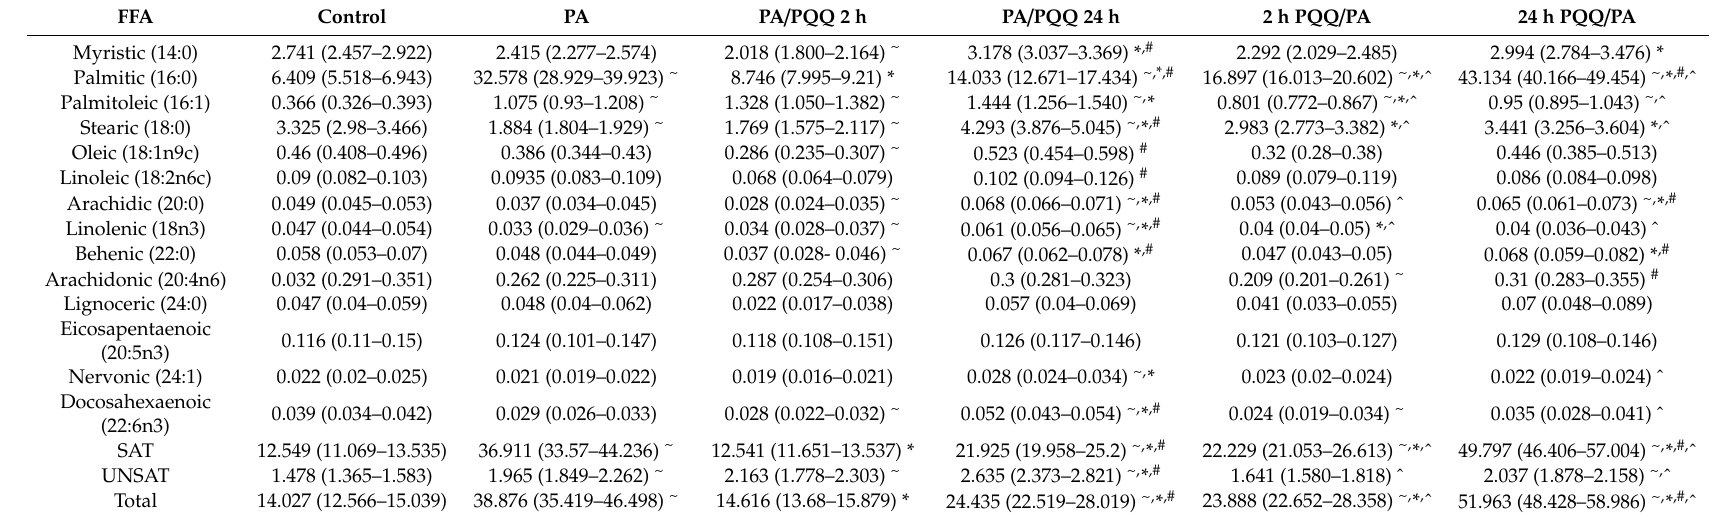
Table A1. Free fatty acids (FFA) content and composition in L6 muscle cells. The values (nmol mg − 1 of protein) are expressed as: median (25–75%) based on six independent determinations. The Kruskal–Wallis test followed by a post hoc adjustment was applied. ~ p < 0.05, PA versus control; * p < 0.05, study group (co-cultured with PQQ) versus PA; # p < 0.05, time-dependent di ff erences (long- versus short-time incubation with PQQ); ˆ p < 0.05, sequence-dependent di ff erences (pre-incubation with PQQ versus post-incubation with PQQ). PA: palmitic acid; PQQ: pyrroloquinoline quinone; SAT: saturated fatty acids; UNSAT: unsaturated fatty